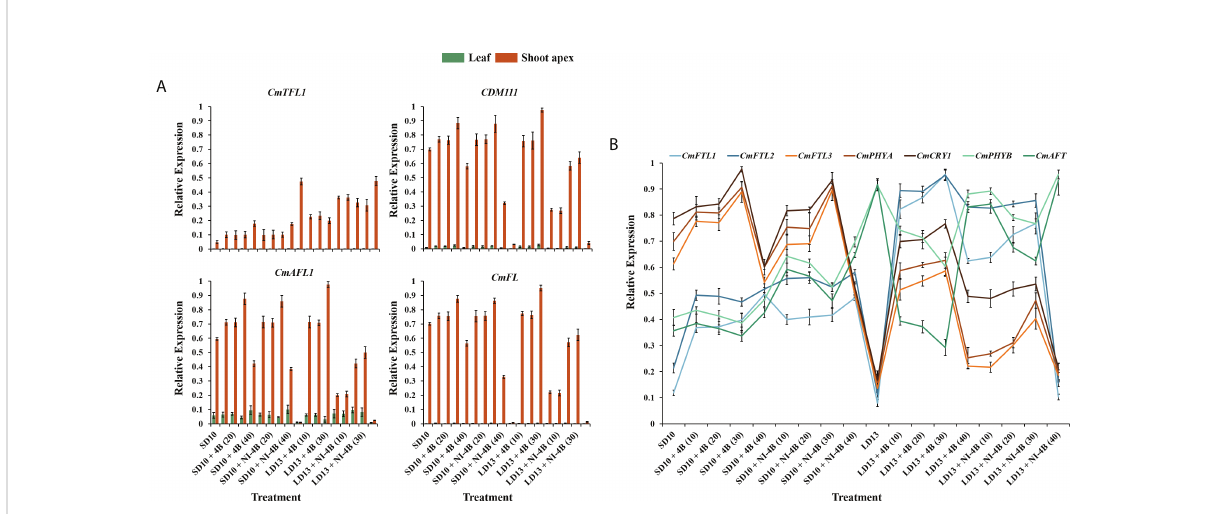
FIGURE 7 Expression patterns of fl owering-related genes in chrysanthemum ‘ Gaya Glory ’ under different intensities of supplemental or night-interruptional blue light, after 60 days of exposure to the photoperiodic light treatments: (A) the tissue-speci fi c expression patterns of fl owering-related genes in leaves and shoot apexes and (B) the expression levels of fl owering or photoreceptor-related genes in leaves. The top leaves (the fourth true leaves from the shoot apex) and shoot apexes were harvested at ZT4 (4 h after lights-on, from 8:00 a.m.) for RNA extraction and RT-PCR. Data were averagely normalized against the expression of CmACTIN and CmEF1 a . The maximum value in each experiment was set to “ 1 ” . Vertical bars indicate the means ± standard error of six biological replicates (n = 6), using RNA from separate plants. See Figure 1 for details of photoperiodic light treatments with blue